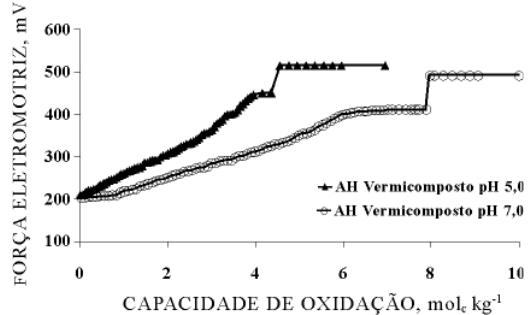
Figura 2. Titulações redox de 6,25 mg de ácido húmico (AH), suspenso em KCl 0,05 mol L -1 e solução-tampão fosfato 0,05 mol L -1 , a pH 5,00 e